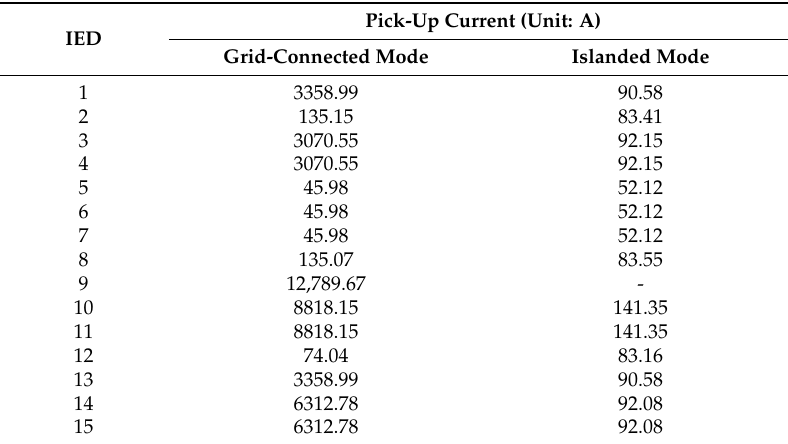
Table 2. Pick-up current for